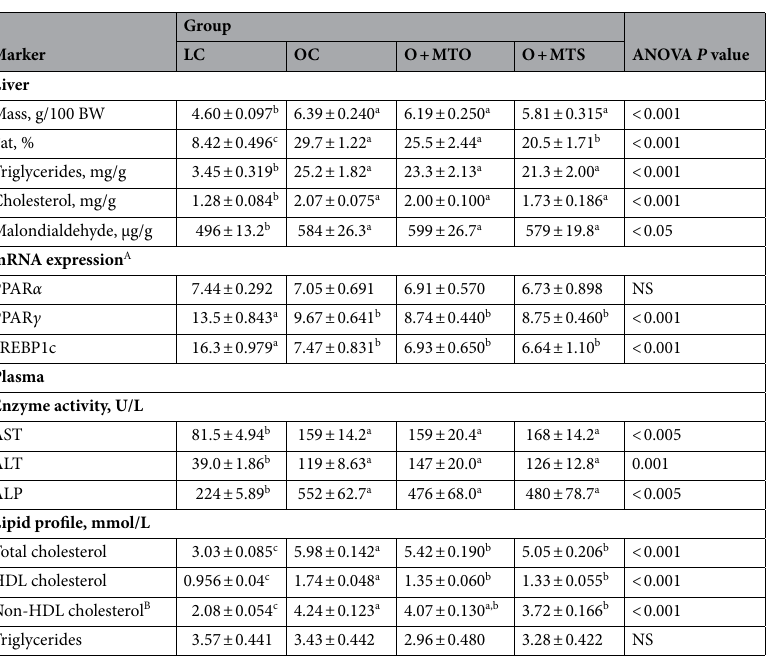
Table 5. Markers of the liver function and lipid metabolism in lean and obese Zucker rats fed a diet containing milk thistle seed oil (+ MTO) or milk thistle seeds (+ MTS) for 5 weeks. Values are means ± SEMs, n = 7–8. Labeled means in a row without a common letter (a,b,c) differ at P ≤ 0.05 (Duncan’s or Dunn’s post hoc test). AST aspartate transaminase, ALT alanine transaminase, ALP alkaline phosphatase, BW body weight, NS nonsignificant, P > 0.05, PPARα peroxisome proliferator-activated receptor α , PPARγ peroxisome proliferator- activated receptor γ , SREBP1c sterol regulatory element binding protein 1c, LC lean control, OC obese control, O + MTO obese fed a diet containing milk thistle seed oil, O + MTS obese fed a diet containing milk thistle seeds. A Gene expression/ β -actin × 10. B Non-HDL cholesterol was calculated as the difference between total cholesterol and HDL cholesterol.